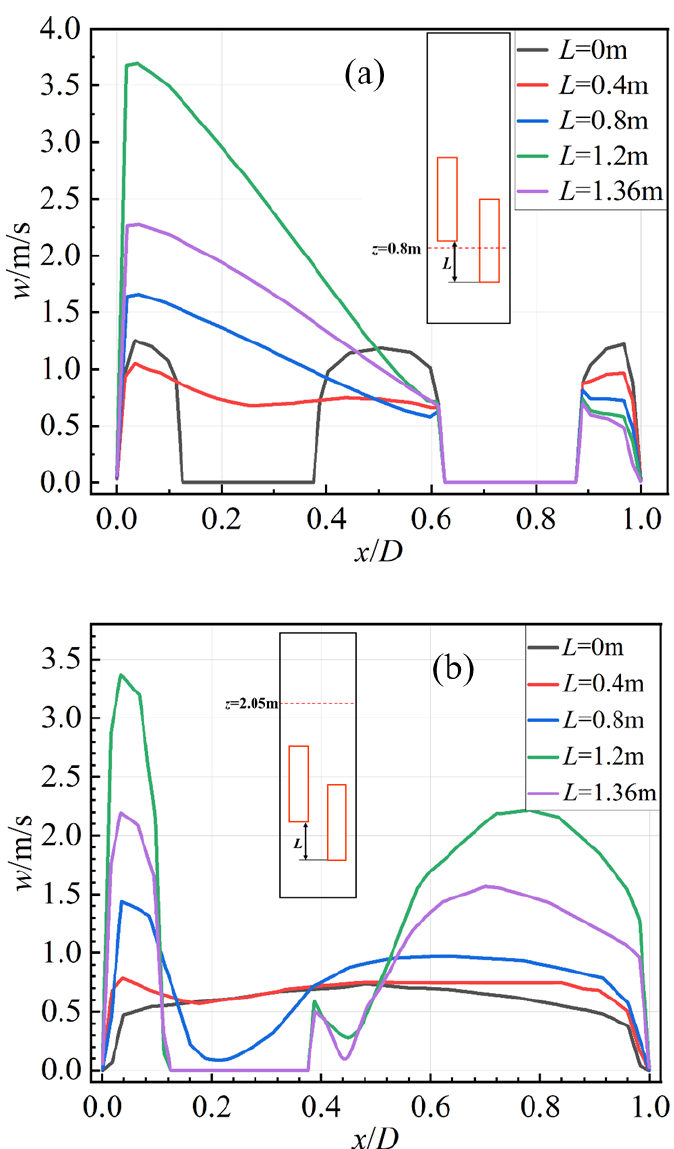
Figure 8. The vertical velocity distributions on the cross sections with different L . ( a ) z = 0.8 m. ( b ) z = 2.05 m.